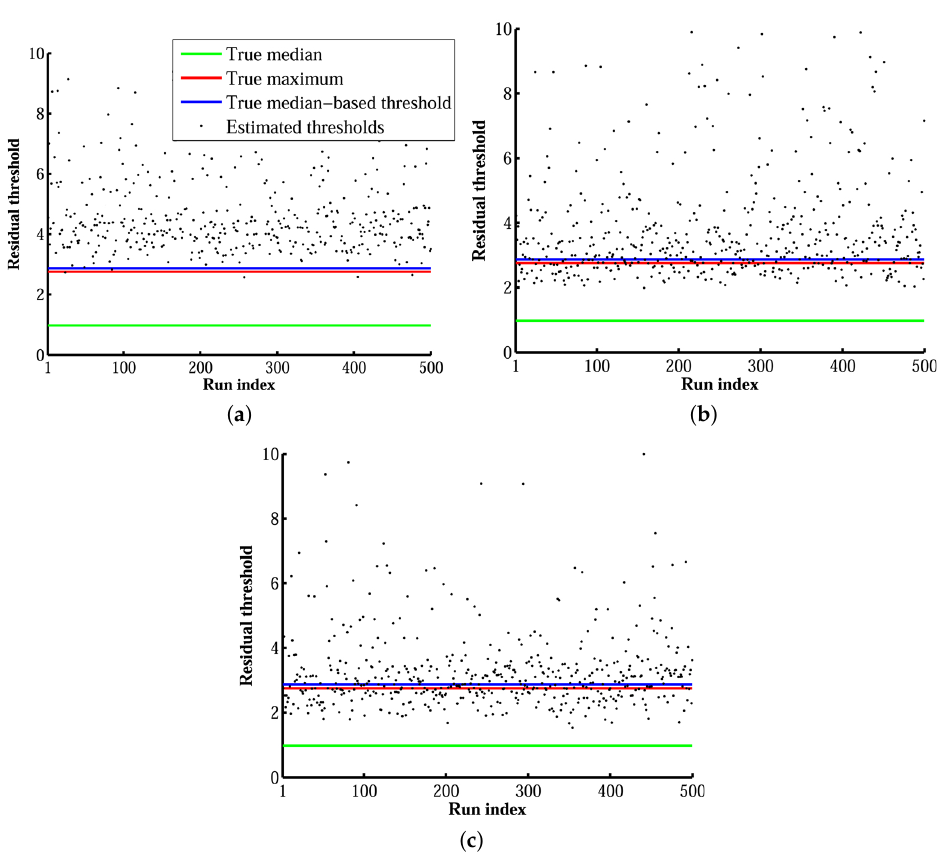
Figure 7. Inlier thresholds determined by ( a ) our adaptive thresholding method; ( b ) the median-based algorithm and ( c ) the covariance-based